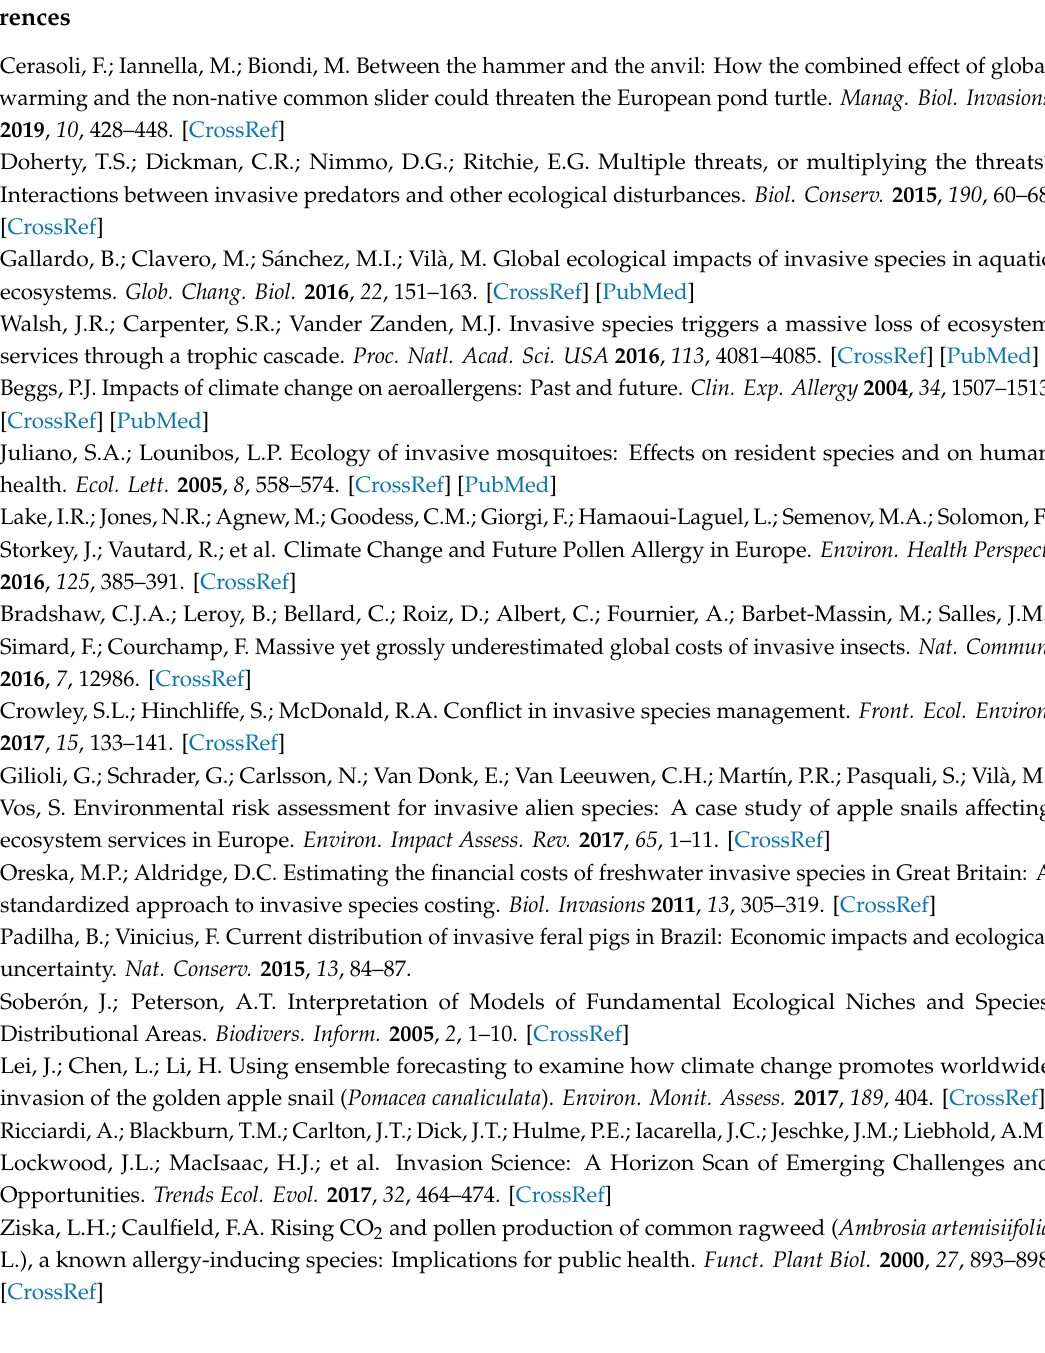
Table S1: Table reporting localities used for the analyses, with the corresponding coordinates in decimal degrees, rounded to three decimal places (datum: WGS84). Table S2: Correlation matrix calculated for the 19 candidate